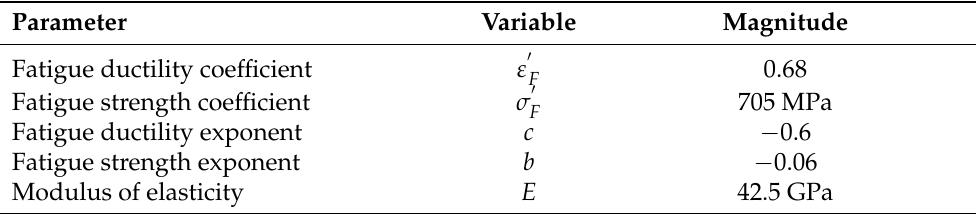
Table 2. Material properties used to characterize the fatigue behavior of NiTi alloy [28,40].